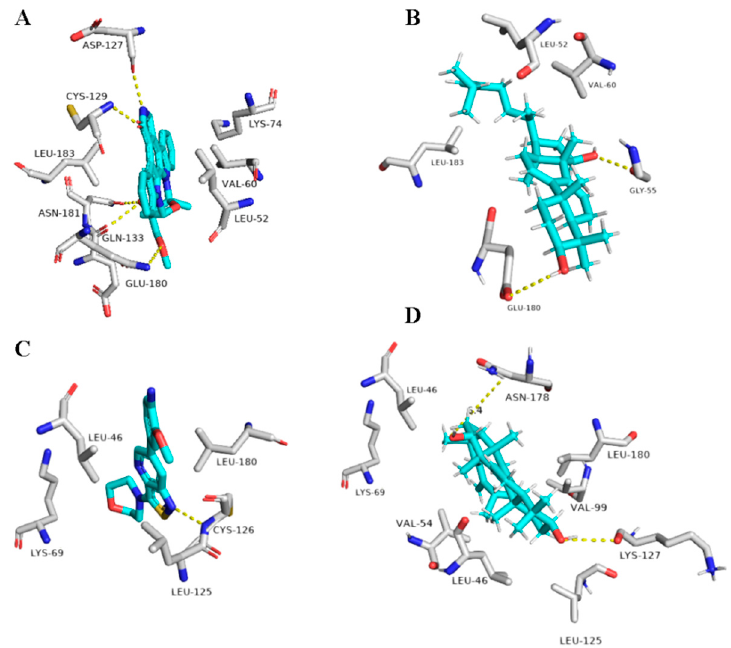
Figure 11. Binding modes of Suberosol (16) inside the human-based targets. ( B , D ) Interactions inside both AAK1 and GAK, respectively. ( A , C ) co-crystallized ligands of AAK1 and GAK, respectively. The G. lucidum -derived triterpene 20(21)-dehydrolucidenic acid (12) has been shown previously in vitro antiviral activity against both HIV and HCV [95]. In addition, it gave an in- teresting docking score with the human-based target GAK (Binding energy = − 8.1 kcal/mol). Being a polyhydroxylated triterpene, 20(21)-dehydrolucidenic acid (12) was able to interact with six amino acid residues inside the enzyme’s active site through 9 H-bonds together with two hydrophobic interactions with VAL-54 and LEU-180 (Figure